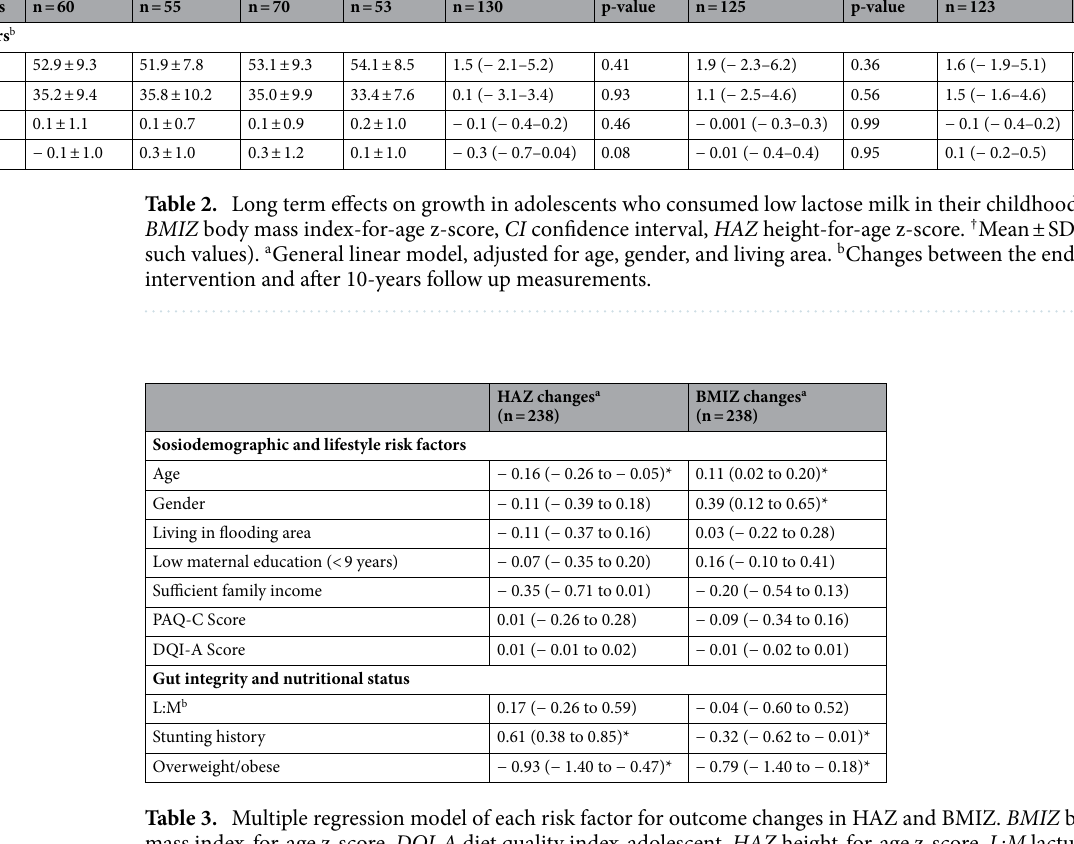
Table 3. Multiple regression model of each risk factor for outcome changes in HAZ and BMIZ. BMIZ body mass index-for-age z-score, DQI-A diet quality index-adolescent, HAZ height-for-age z-score, L:M lactulose/ mannitol ratio, PAQ-C physical activity questionnaire-children. a Values are standardized effect sizes. b Tested and analyzed in 155 subjects. *Generalized linear model with p-value < 0.05.